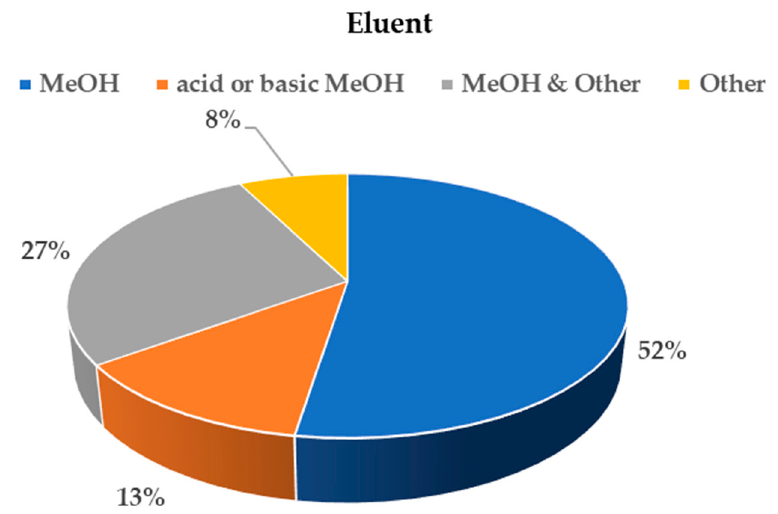
Figure 3. Percentage of studies according to the type of eluent used.